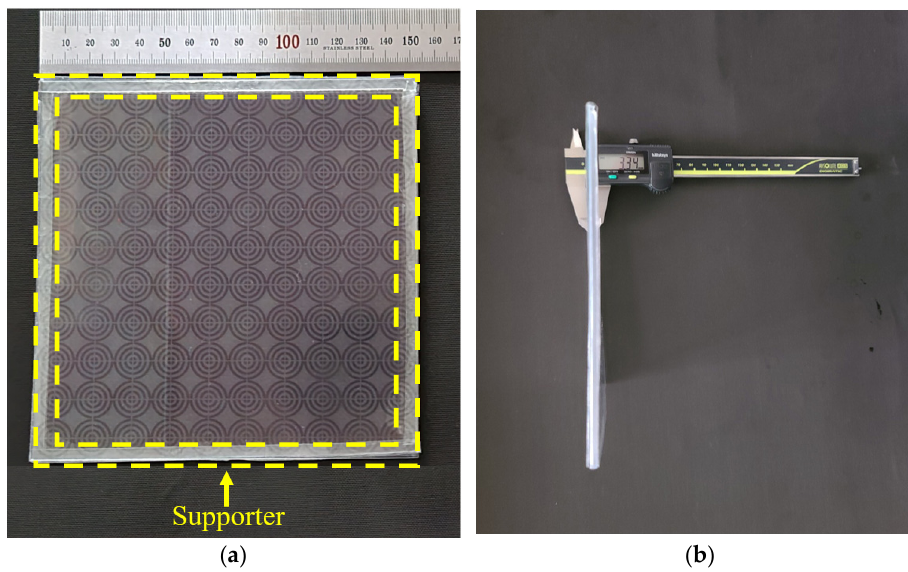
Figure 7. Fabrication of the proposed absorber. ( a ) Top view, and ( b ) side view. Photos of the measurement setup are shown in Figure 8. With the built prototype in front of the commercial pyramidical absorbers, as shown in the photos, its performance was measured using horn antennas with an operating frequency of 1–18 GHz and 18–27 GHz, respectively, to test the entire wideband absorbance frequencies of the proposed design from 7.2 GHz to 27 GHz. Note that the horn antenna was placed close to the proposed absorber to present clear photos of the measurement setup, but they were separated by 2 m when carrying out the measurement to satisfy the far-field condition. As shown in Figure 8a, the absorption rate according to the polarization angle φ was measured by rotating the proposed absorber by 0 ◦ , 45 ◦ , and 90 ◦ . This realizes the case described in Figure 6a. The measurement setup in Figure 8b shows the setup for measuring the absorbance according to the incidence angle of the TE mode (i.e., the case of Figure 6b). The same two horn antennas are positioned based on the difference in the angle of θ according to the protractor on the ground. The measurement is then carried out by varying θ from 0 ◦ to 30 ◦ by 15 ◦ . The TM mode measurement, in the case of Figure 6c, is made by rotating the horn antennas by φ = 90 ◦ . A copper plate is measured first, instead of the proposed absorber, for use as a reference. It is then subtracted from the measurement result of the proposed absorber. In this manner, any possible noise and destructive influence from the measurement environment can be excluded.